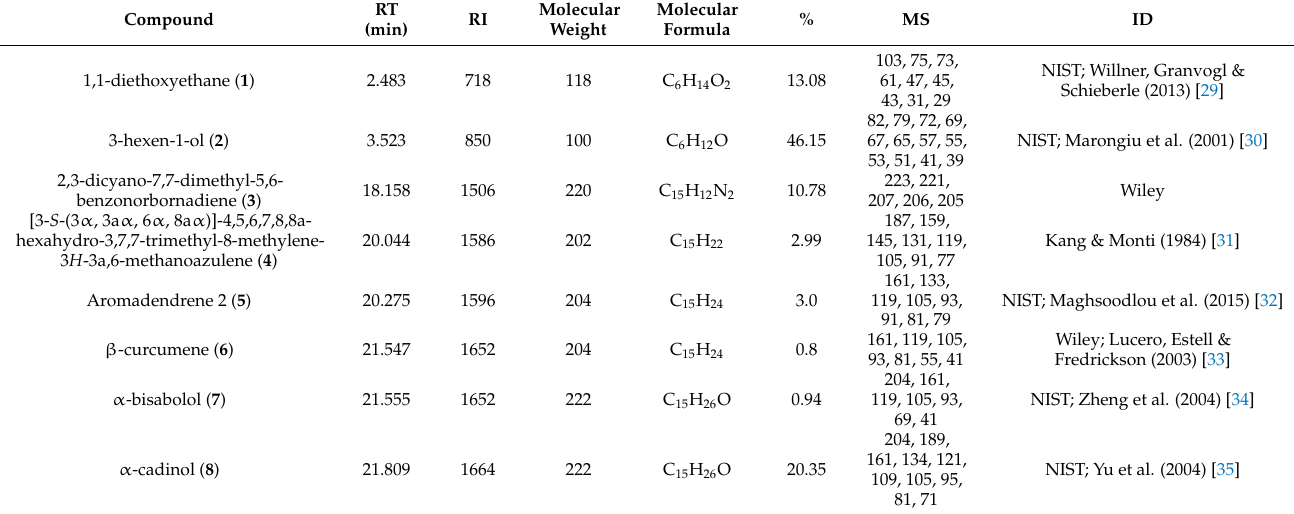
Table 1. Chemical compounds identified in essential oil from Campomanesia lineatifolia fresh leaves by gas chromatography–mass spectrometry. For methodology, see Material and